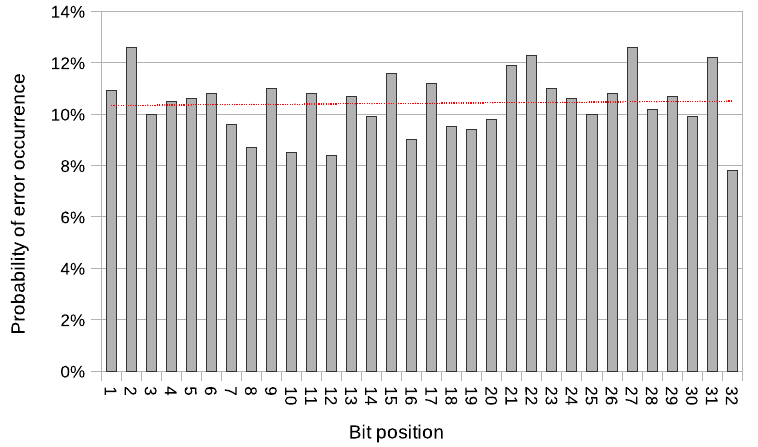
Figure 21. Probability of error occurrence as a function of bit position with a trend line (IEEE 802.11ac;